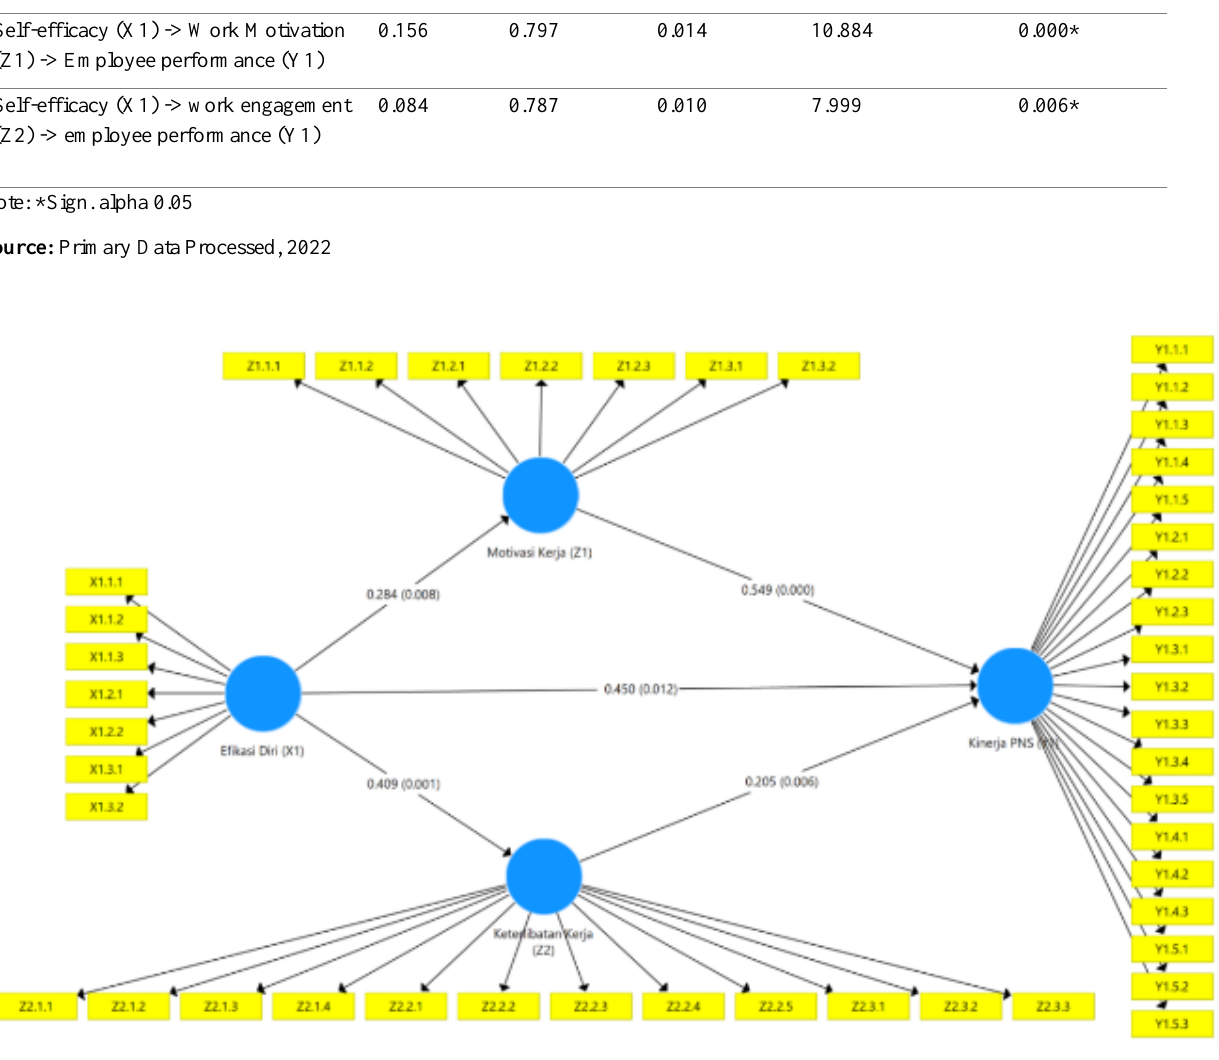
Figure 1: Beta and